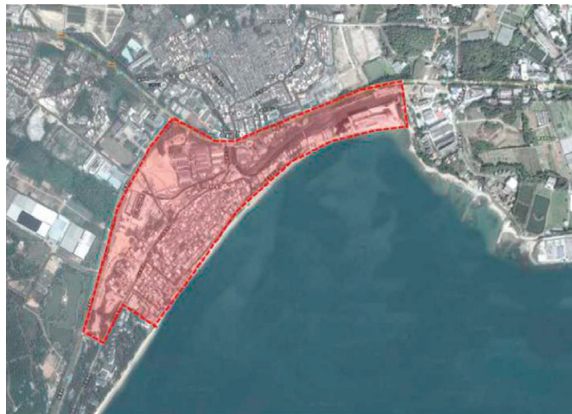
Figure 4: The spatial layout of the village selected for this